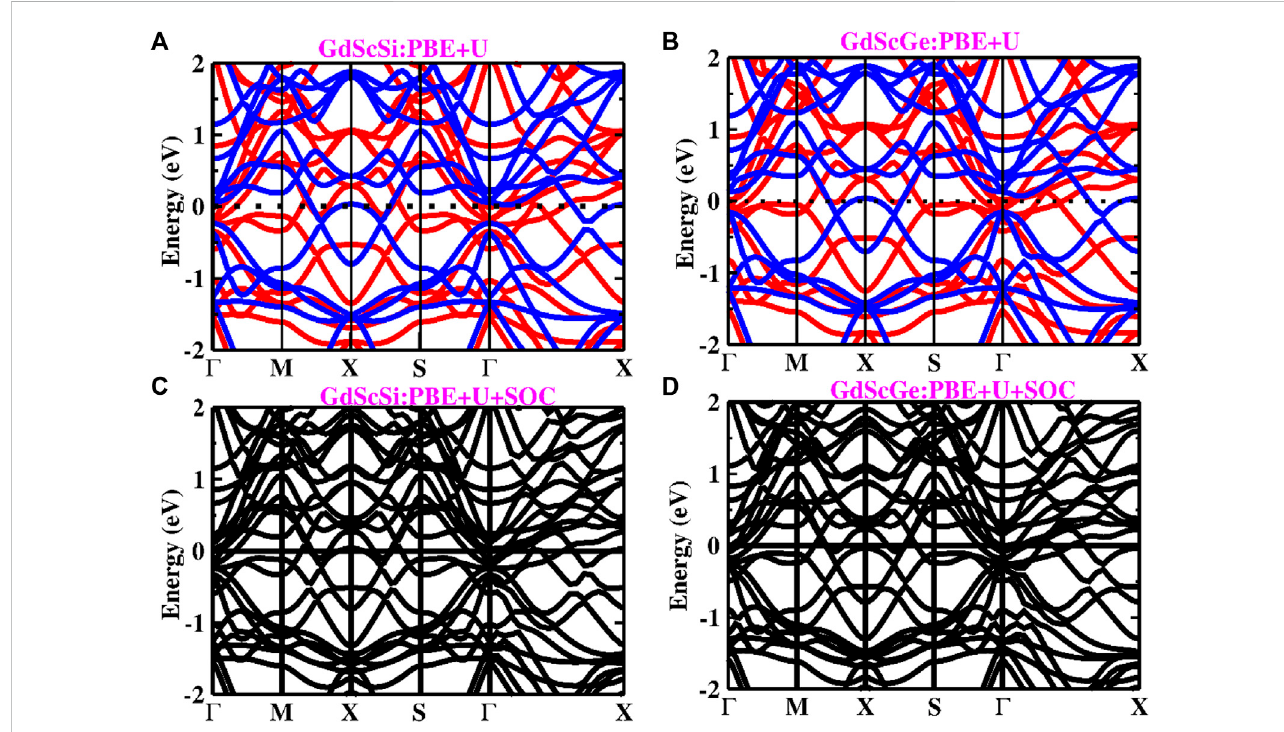
FIGURE 4 Band structures of the GdScSi monolayer (A, B) and GdScGe (C, D) monolayer determined using PBE + U and PBE + U + SOC methods.